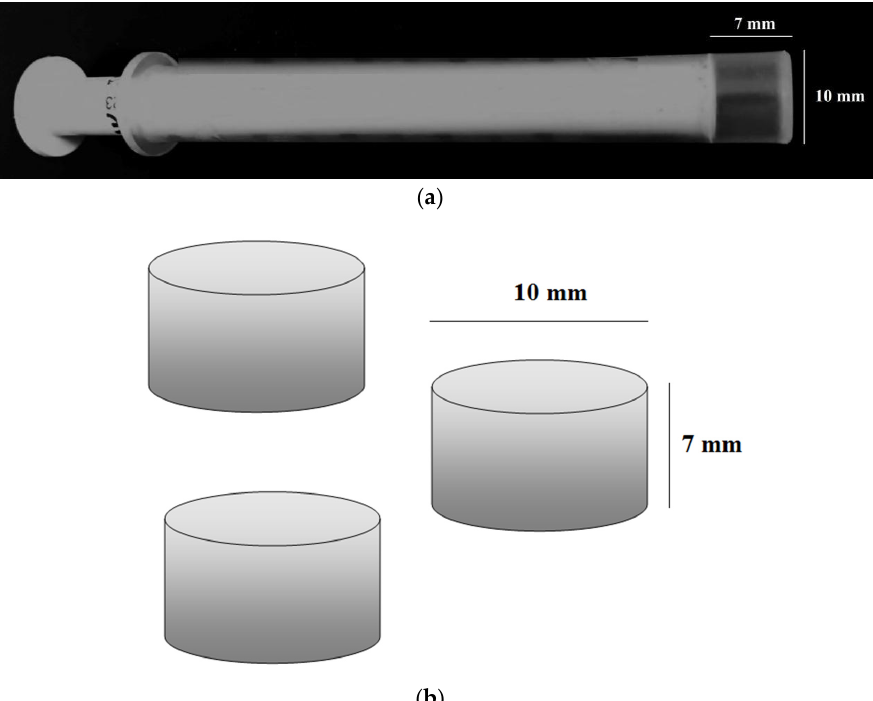
Figure 1. Photo of the plastic syringe used in cylinder formation ( a ) and schematic representation